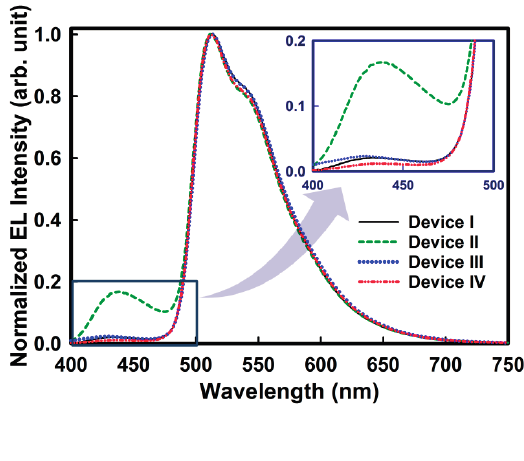
Figure 5. Normalized EL spectra of the fabricated OLEDs at 1000 cd/m 2 . The inset figure shows the enlarged EL spectra in the range of 400 to 500 nm of